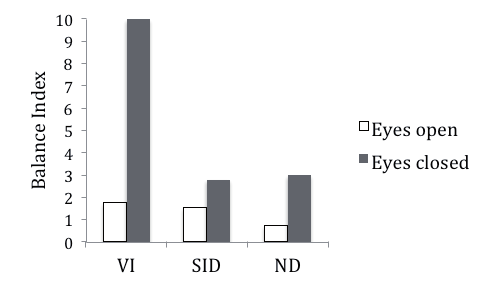
Mean scores of the Balance Index in stance on right leg (VI – visual impairment, SID – severe intellectual disability, ND –